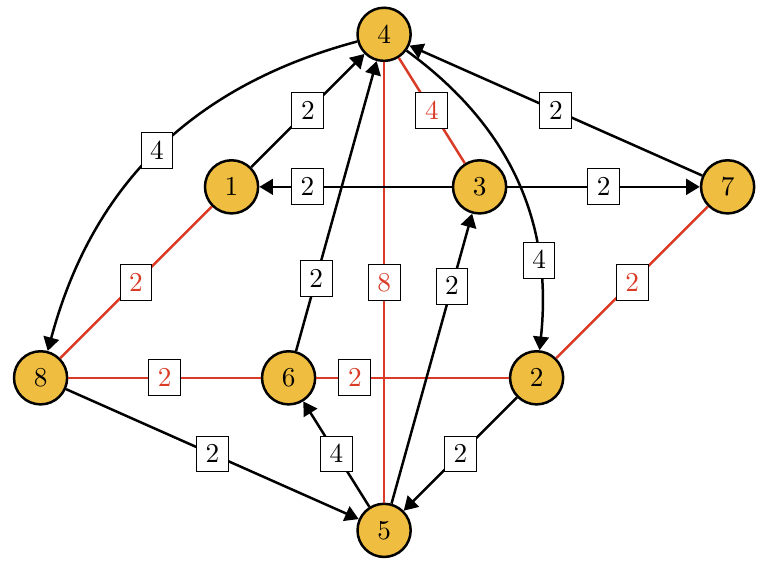
Figure 27 . Quiver diagram for phase H of Q 1 , 1 , 1 / Z 2